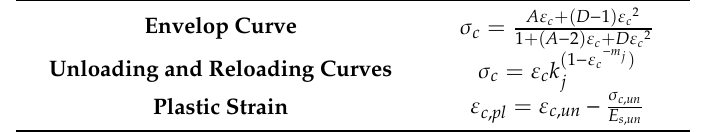
Table 3. Constitutive model for masonry under cyclic compression: Mendola and Papia [35].